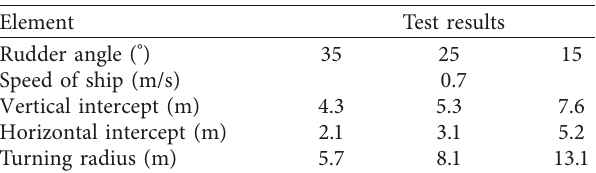
Figure 8: Trajectory in the turning test recorded by DGPS. Table 4: Turning test data.